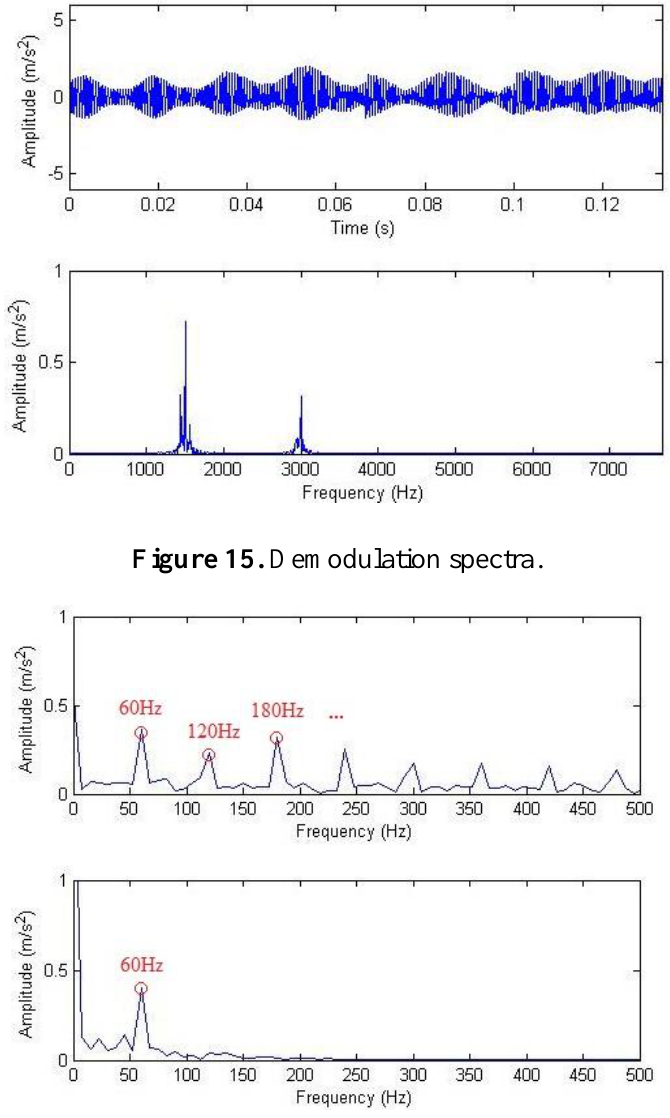
Figure 14. Harmonic component with hard threshold.